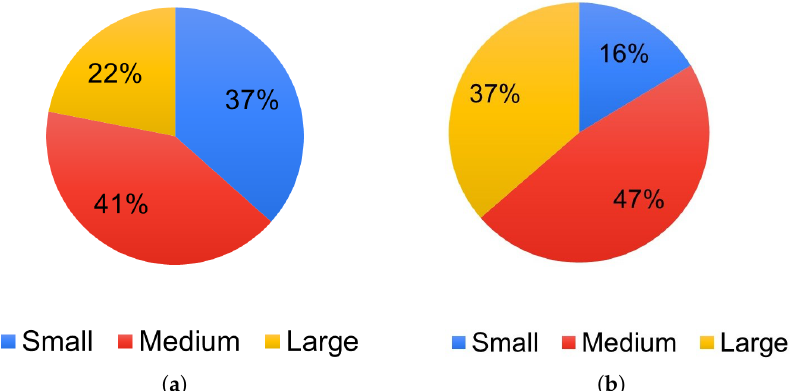
Figure 7. Distribution of refrigerators inventoried at the national level according to climatic class: ( a ) Tropical [T] and ( b ) Subtropical [ST].